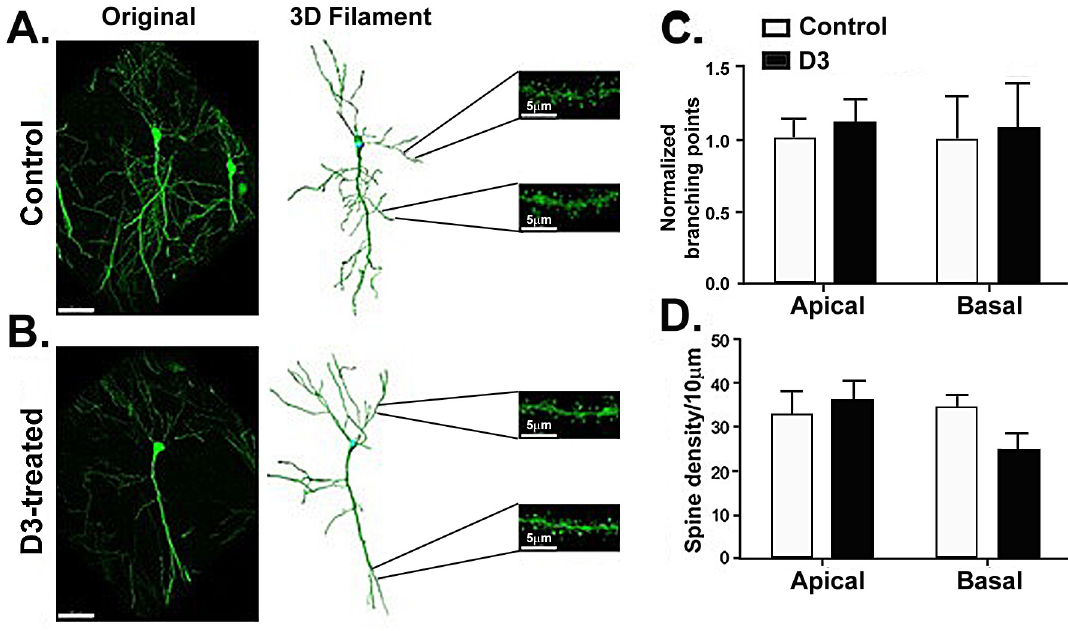
Fig 5. D3 has no effect on neuronal arborization in the CA3 region. (A) Representative confocal image, 3D filament, and magnified segments from apical and basal CA3 tertiary dendrites of an independent neuron from a control mouse. (B) Representative confocal image, 3D filament, and magnified segments from apical and basal CA3 tertiary dendrites of an independent neuron from a 2-week D3-treated mouse. ( C ) Quantification of branching in the apical and basal regions shows no difference between the control and the D3-treated mice (p = 0.796; controls n = 8, D3 n = 9). Total branching points of neurons belonging to D3-treated mice were normalized to the total branching points of the controls. ( D ) Spine density in the CA3 region was quantified and is expressed in spines/ 10 μ m; no significant differences were observed with D3 treatment in either of the